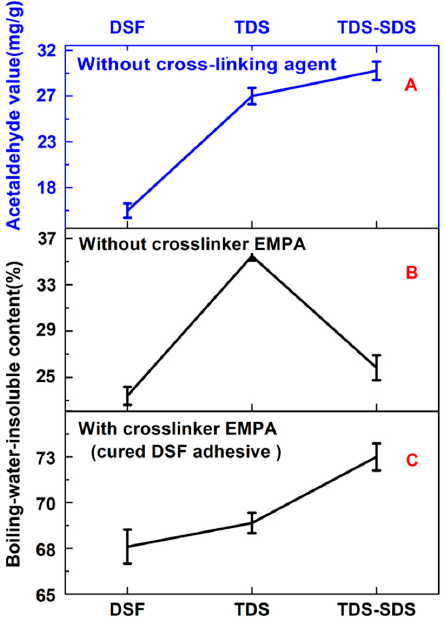
Figure 2. ( A ) Acetaldehyde values and ( B , C ) boiling-water-insoluble contents of various DSF samples.